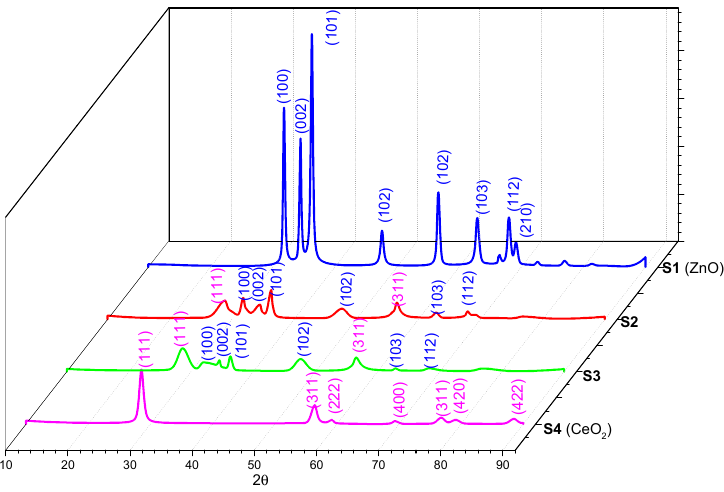
Figure 1. XRD patterns of the S1–S4 samples.